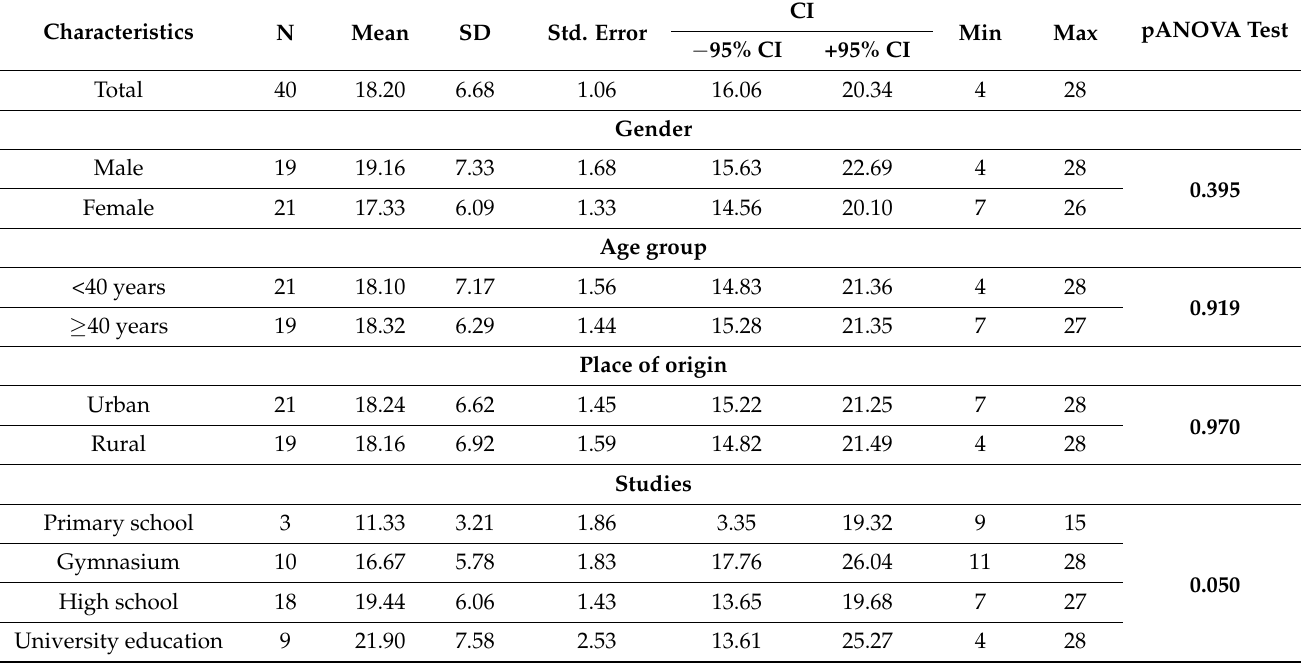
Table 3. Descriptive statistical indicators of the risk scores for